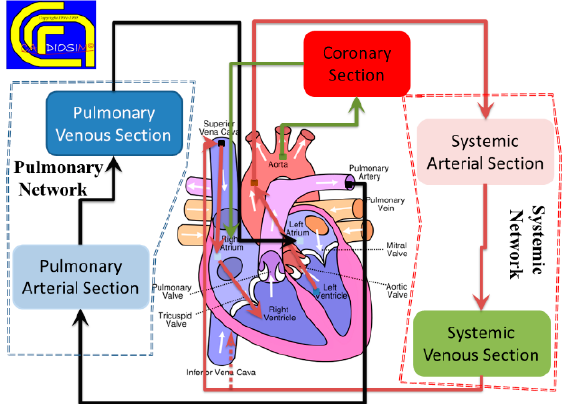
Figure 3. Schematic representation of the different sections implemented in the software cardiovascular simulator platform. (Reprinted with permission from [39], Copyright © 2022–2019 C. De Lazzari.) The left (right) ventricular filling and ejection phases are described separately in the